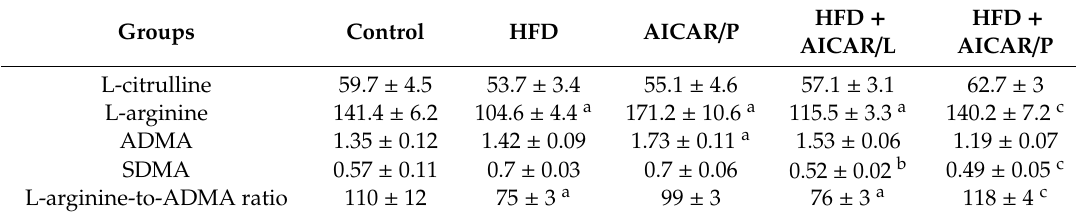
Figure 5. ( A ) Light microscopic findings of PPAR coactivator-1 α (PGC-1 α ) immunostaining in the kidney cortex in 16-week-old male o ff spring. Bar = 50 µ m; ( B ) quantitative analysis of PGC1 α -positive cells per microscopic field (400 × ); * p < 0.05 vs. control, # p < 0.05 vs. HFD. Table 3. Plasma l -citrulline, l -arginine, ADMA, and SDMA levels in 16-week-old male o ff spring exposed to high-fat diet (HFD) and AICAR in pregnancy or